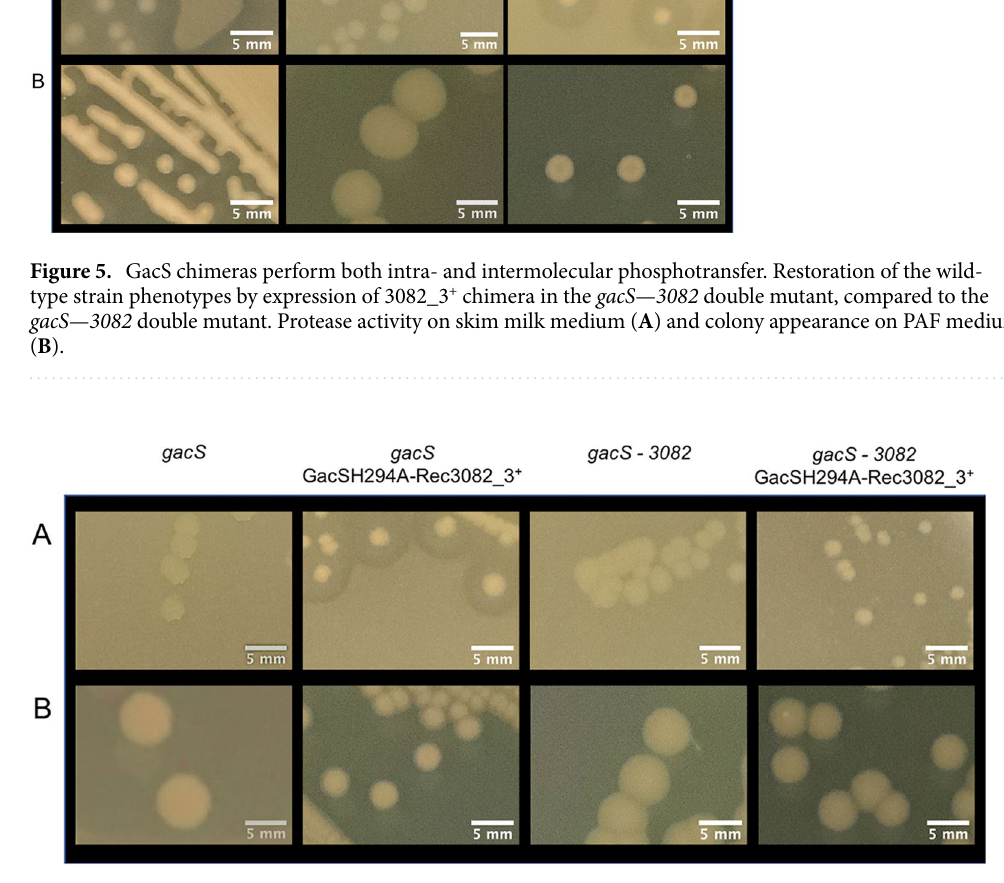
Figure 6. Transplanted receiver domain in a GacS chimera also occurs via cross-talk. Restoration of the wild-type strain phenotypes by expression of GacSH294A—3082_3 + chimera in the gacS mutant and lack of restoration in the gacS — 3082 double mutant. Protease activity on skim milk medium ( A ) and colony appearance on PAF medium ( B ). The phenotypes of the gacS mutant and the gacS — 3082 double mutant are also